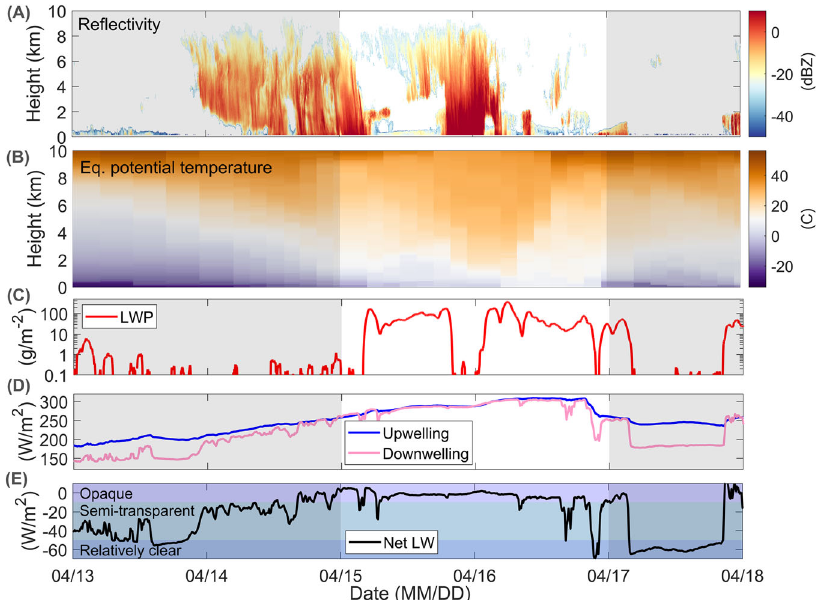
Fig. 7 | Cloud observations during the warm intrusion event. ( A ) Radar re fl ec- tivityshowingthecloudbaseheight,( B )Equivalentpotentialtemperatureshowing the vertical temperature pro fi le, ( C ) Liquid water path ( D ) Upwelling (blue) and